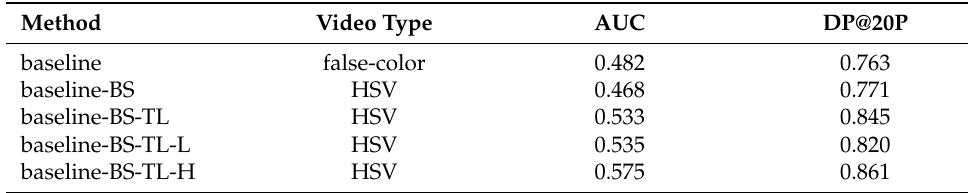
Figure 8. Success and precision plots for the ablation study over all the test HSVs. ( a ) Success plots; ( b ) Precision plots. Table 2. Ablation study over all the test